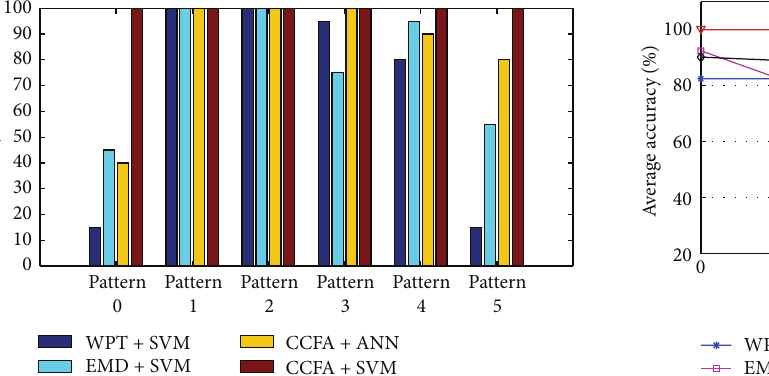
Figure 8: Test accuracy rate with different types of methods.